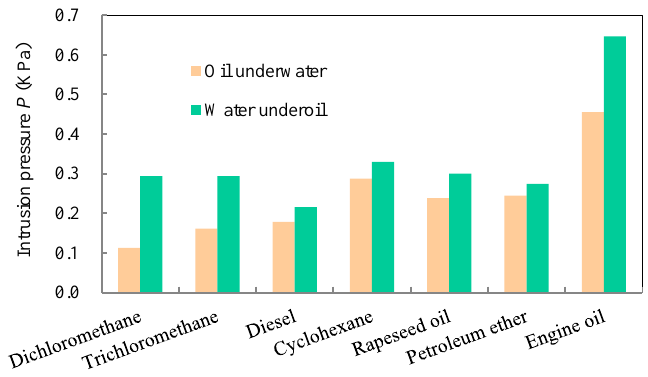
Figure 11. Intrusion pressure of CSQS.